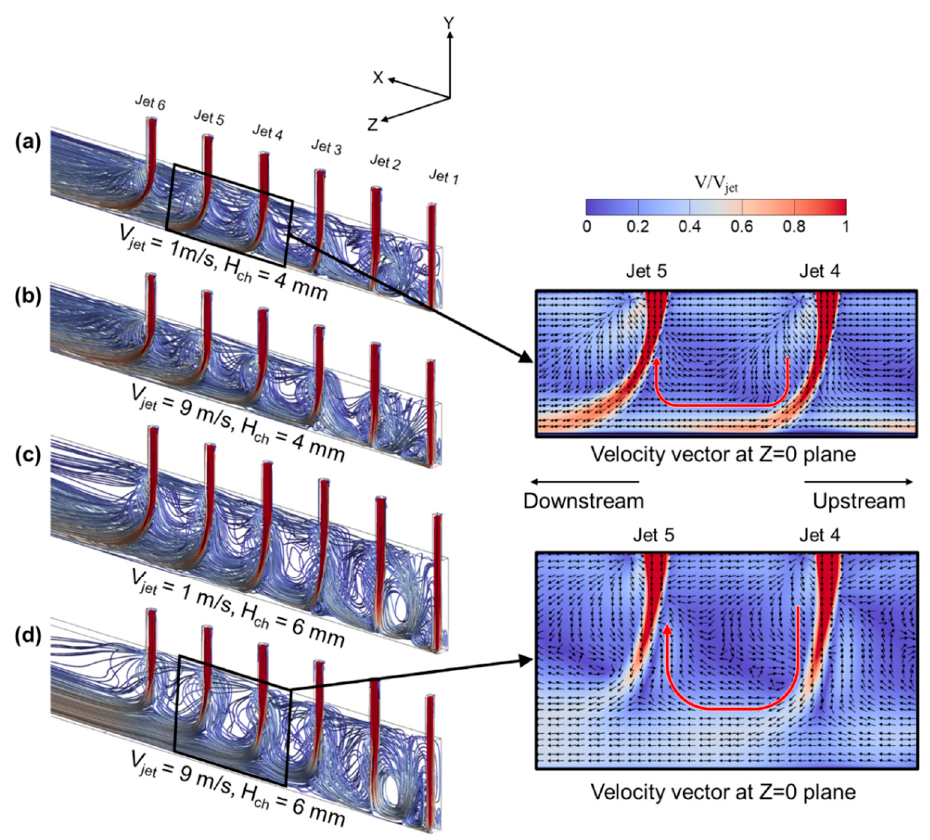
Figure 11. Velocity streamlines for ( a ) V jet = 1 m/s, H ch = 4 mm; ( b ) V jet = 9 m/s, H ch = 4 mm; ( c ) V jet = 1 m/s, H ch = 6 mm; ( d ) V jet = 9 m/s, H ch = 6 mm.